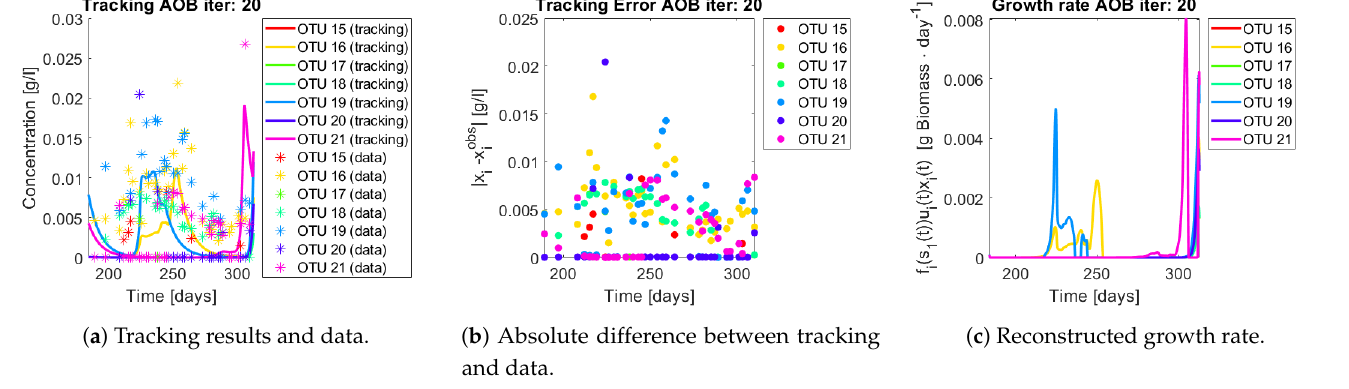
Figure 17. Results for OTU 15-22 (AOB).